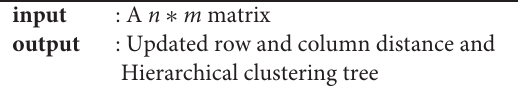
Algorithm 3: Data Mechanics